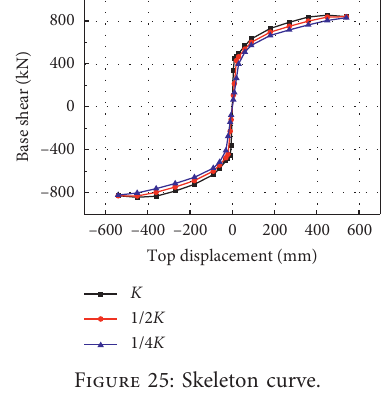
Figure 25: Skeleton curve.